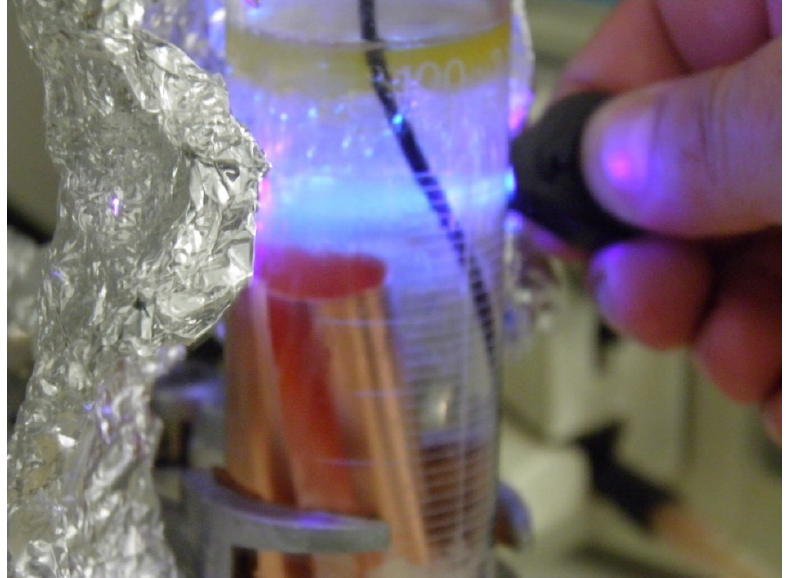
Figure 5. Turquoise fluorescence indicates presence of Eu 2+ washed down from illuminated upper cavity containing chitin and organic substrate. Eu(III) would appear orange to pinkish if emitted at all in this chemical